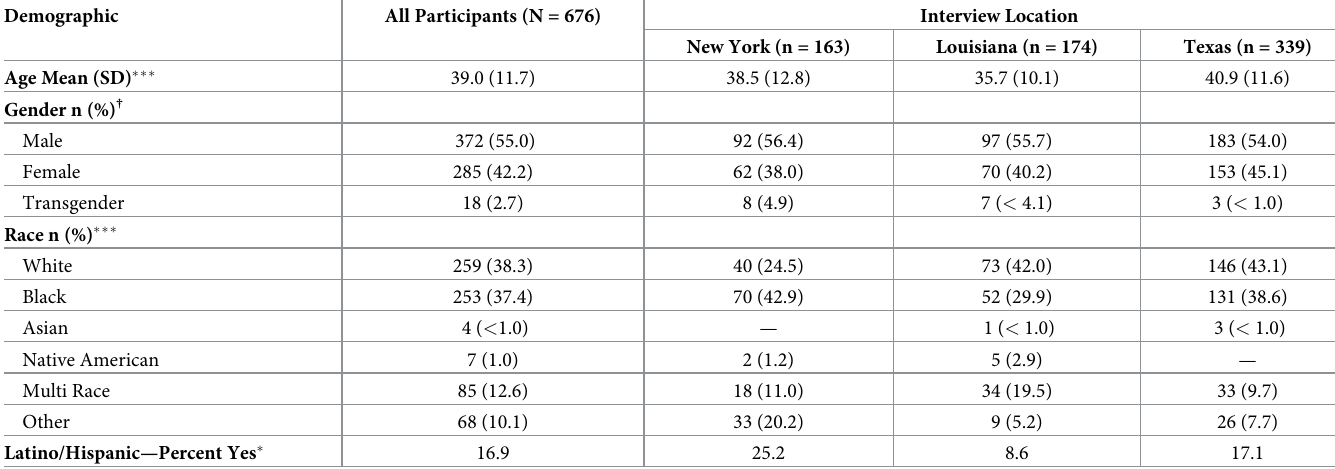
Table 1. Participant